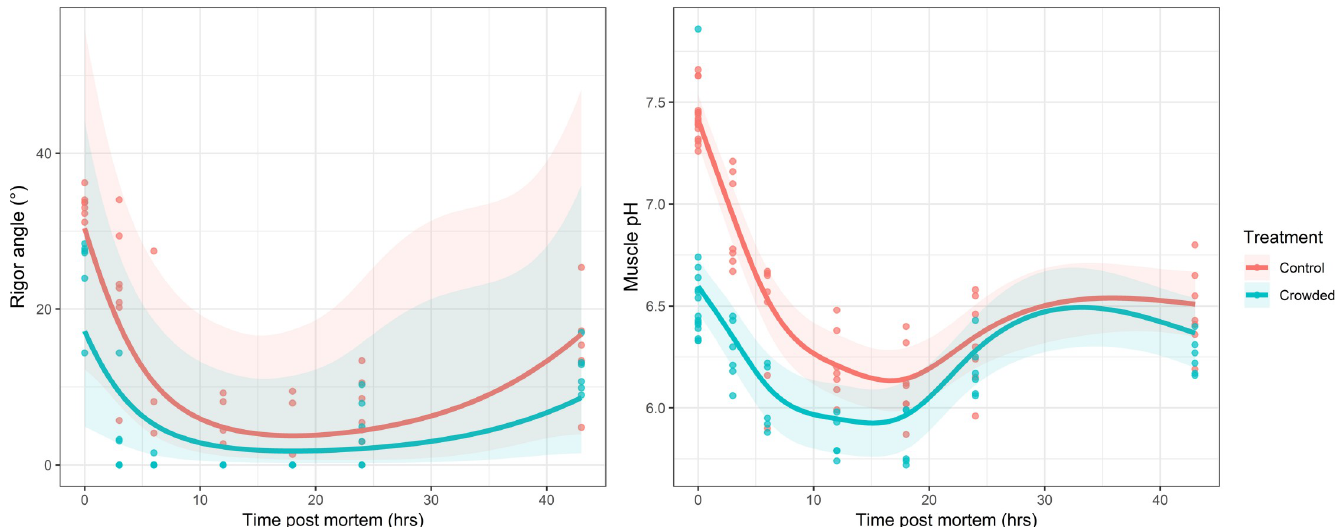
Fig 2. Post-mortem rigor angle development (left panel) and muscle pH (right panel) response to crowding in Atlantic mackerel. The lines indicate the fitted relationship, with the 95% confidence intervals shown as shaded areas. The underlying dataset is shown as filled circles. Data points and lines are coloured according to treatment.